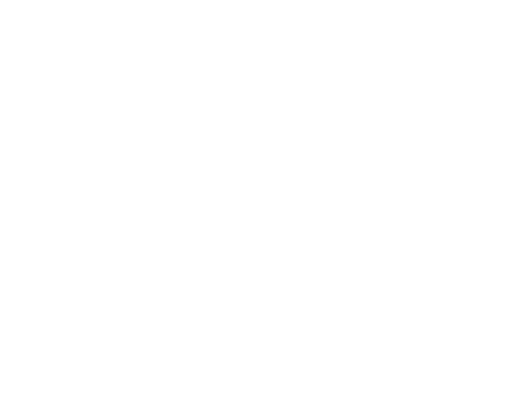
Figure 1. TSH concentration during infection ( 1 ) and during the check-up ( 2 ) in the group of children with elevated TSH concentration at the first examination (during infection).